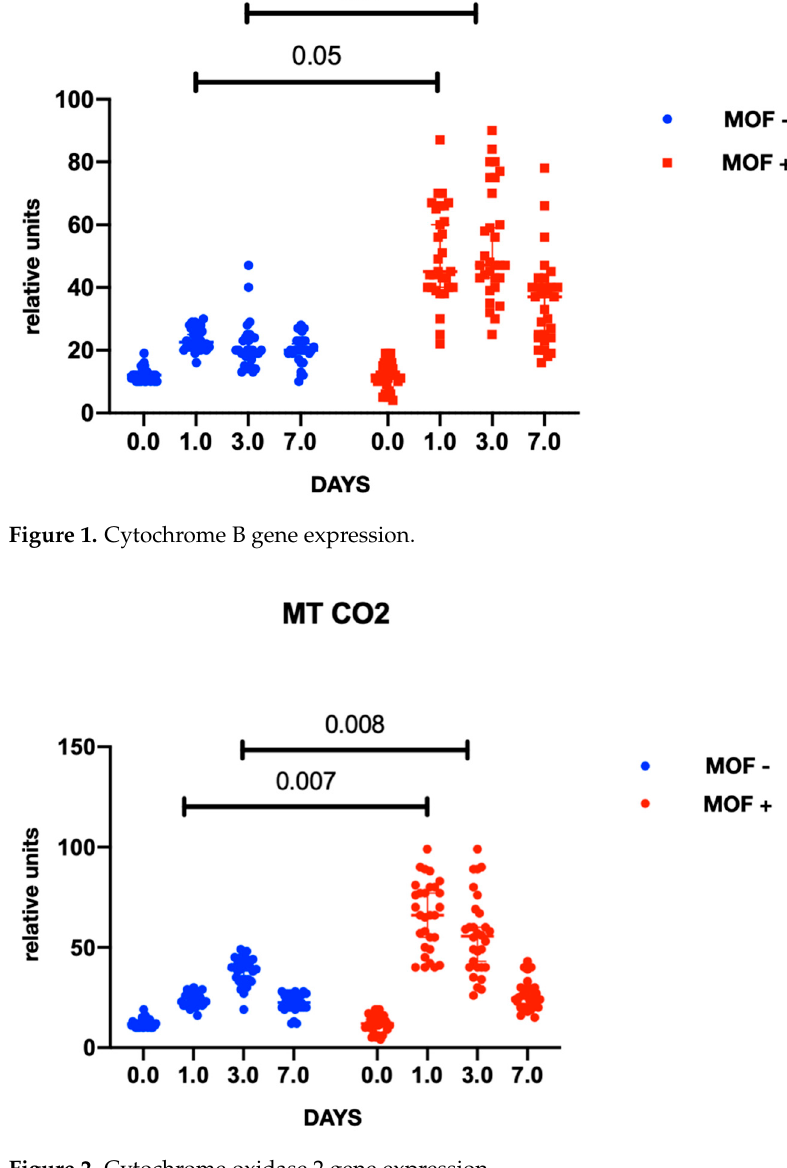
Figure 2. Cytochrome oxidase 2 gene expression.